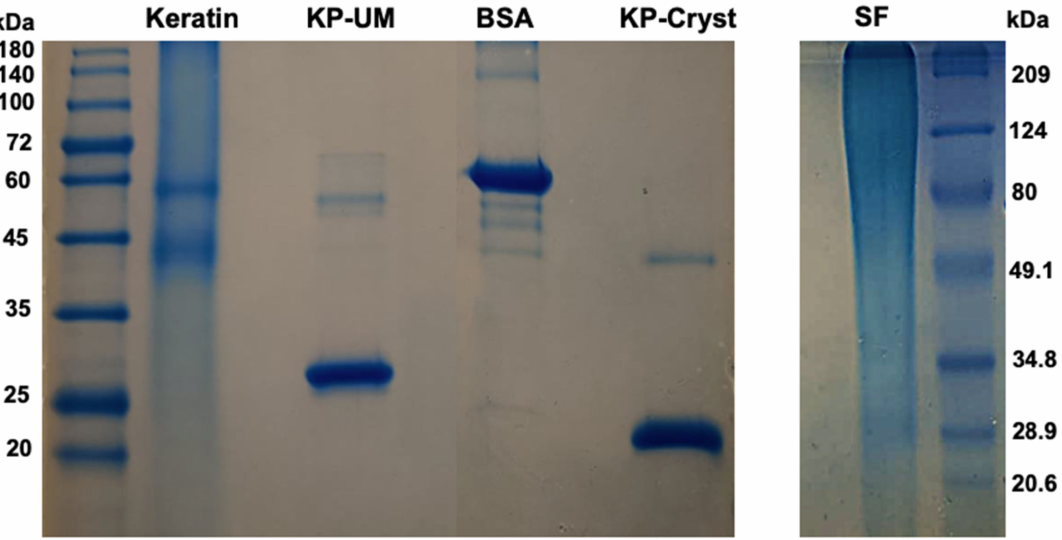
Figure 1. Protein purity analysis by SDS-PAGE in a 12.5% polyacrylamide gel. The tested proteins included keratin, KP-UM, BSA, KP-Cryst and silk fibroin (SF)